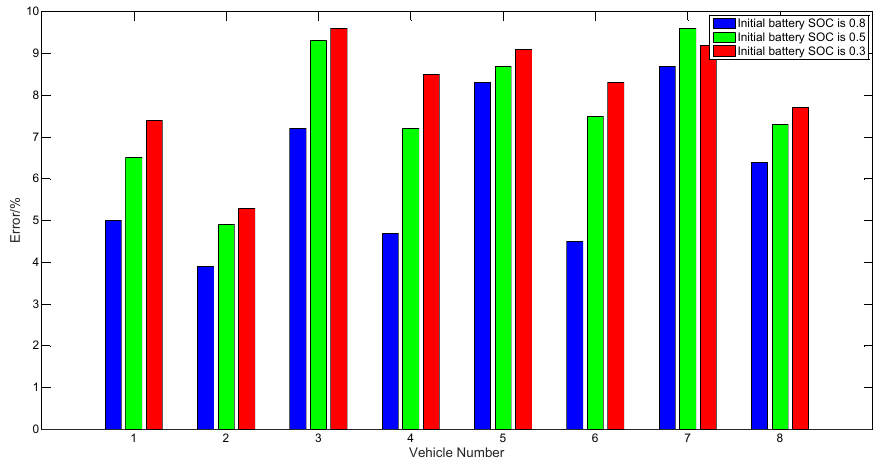
Figure 11. TEEM performance with different initial battery SOCs when the route length is 10 km.